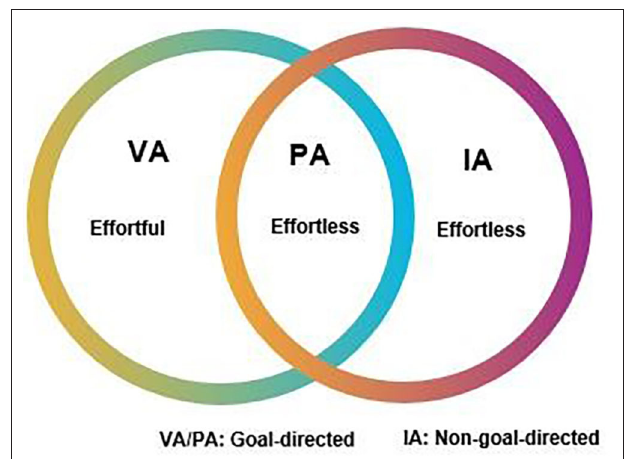
FIGURE 1 | Voluntary attention (VA), postvoluntary attention (PA), and involuntary attention